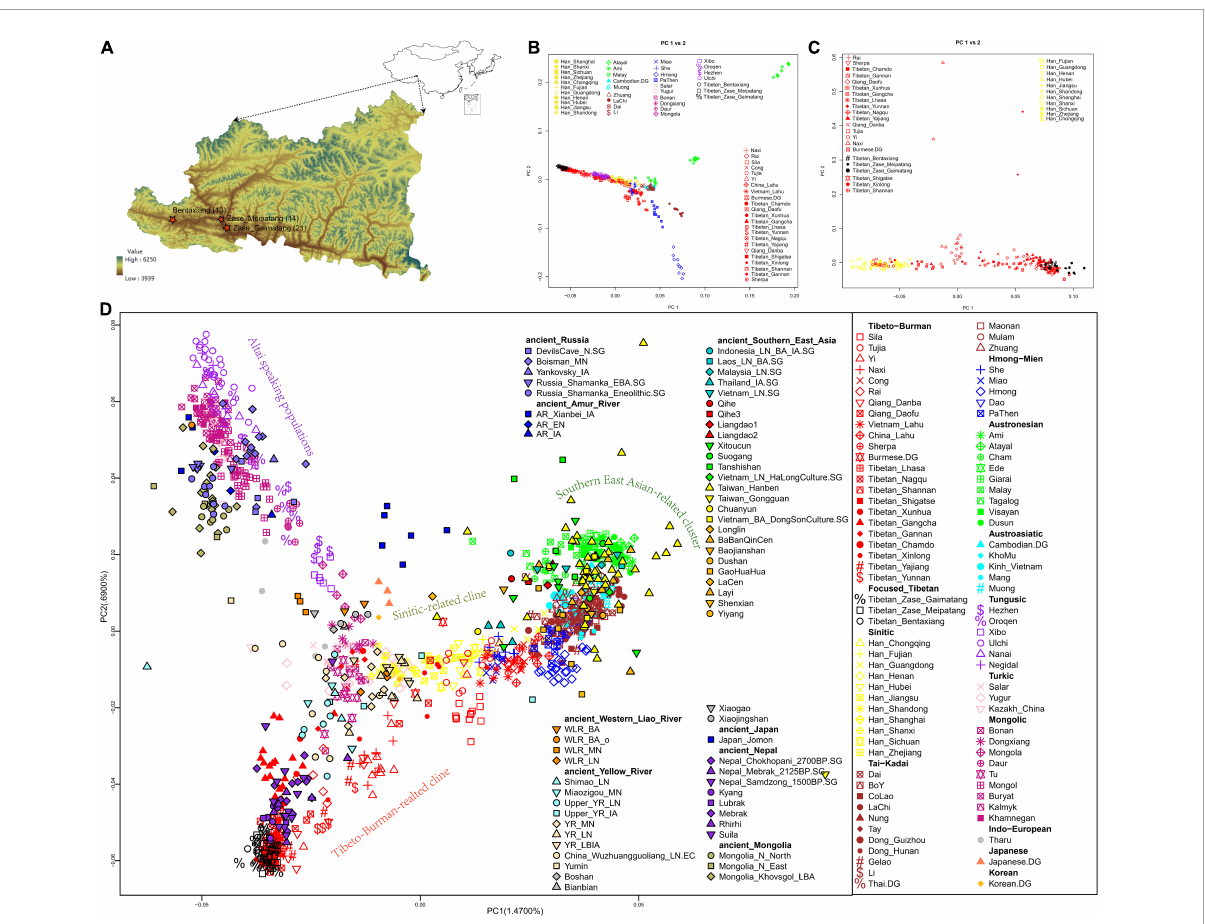
FIGURE1 Geographical locations of our newly collected Nagqu Tibetan samples and genetic population structure of East Asians. (A) Map of our studied three Nagqu Tibetan populations. Sample sizes were indicated in parentheses. Map of East Asia was plotted via R package “map” (top-right), and the relief map of Baqing County was plotted using ArcGIS (bottom-left). (B,C) Haplotype sharing-based PCA that focused on (B) present-day East Asians and (C) Sino-Tibetan speaking populations were constructed based on the co-ancestry matrix via fineSTRUCTURE. (D) Allele-frequency-based PCA plot focused on present-day and ancient East Eurasians. Populations were color-coded according to the geographical and linguistic